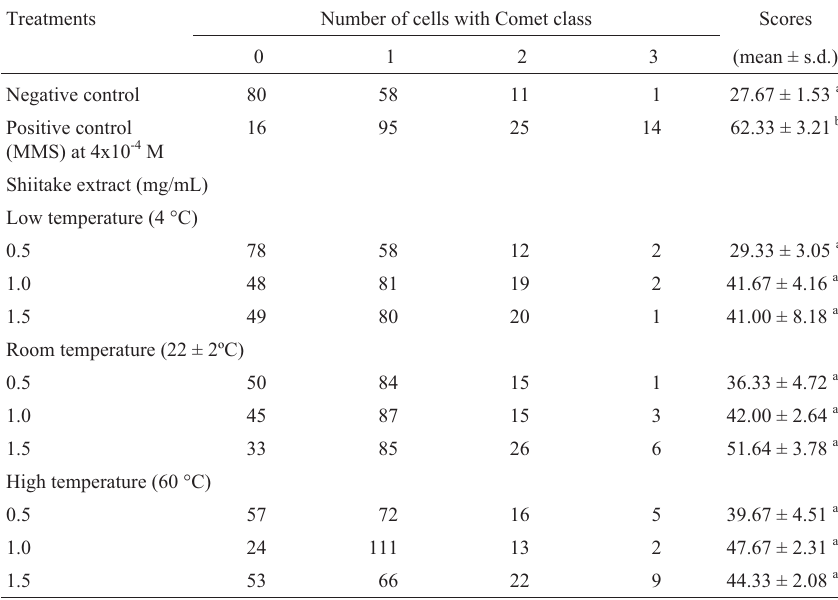
Table 1 - Comet assay scores for HEp-2 cells treated with three different concentrations of shiitake aqueous extracts prepared at three different temperatures for evaluation of genotoxicity. Three replicates were made for each experiment and 50 nuclei were scored per repetition (n= 150